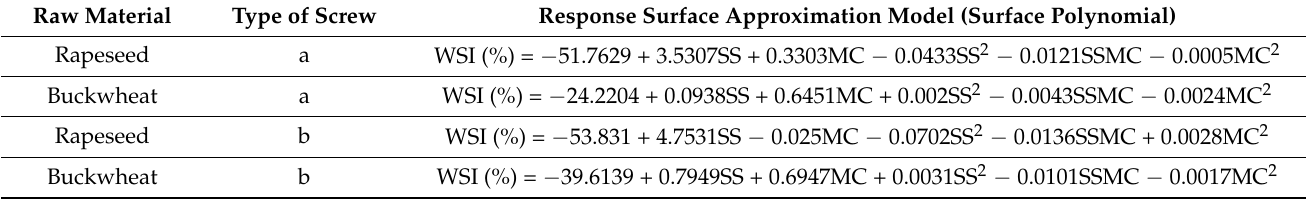
Table 4. Models of response surface approximation for the water solubility index of extruded rapeseed and buckwheat straws depending on the process variables. Response Surface Approximation Model (Surface